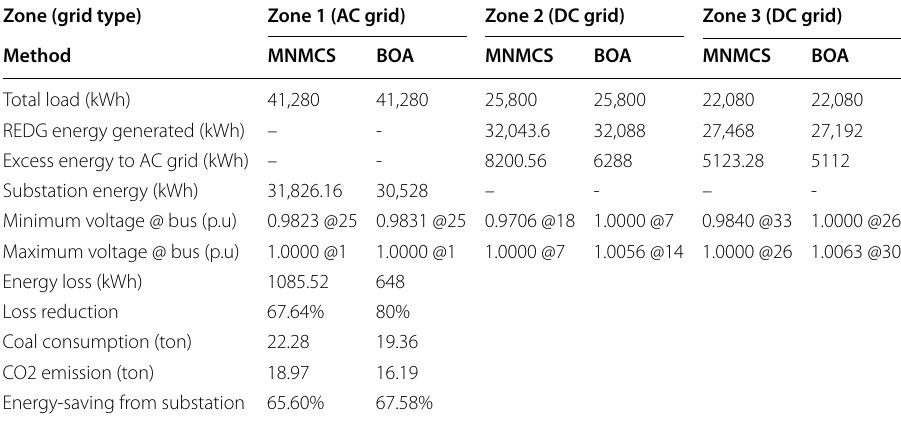
Table 4 Comparison of energy flow in 33-bus AC/DC hybrid distribution Micro-grid under standalone mode of